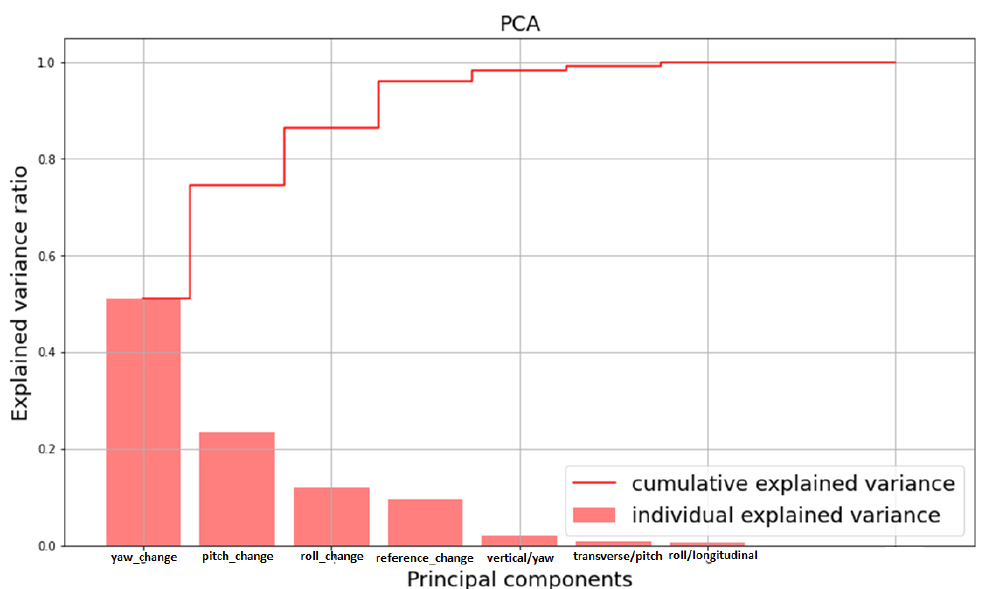
Figure 5. Principal component analysis (PCA) of the considered dataset for detecting attacks (spoofing or jamming) in UAM attitude control.